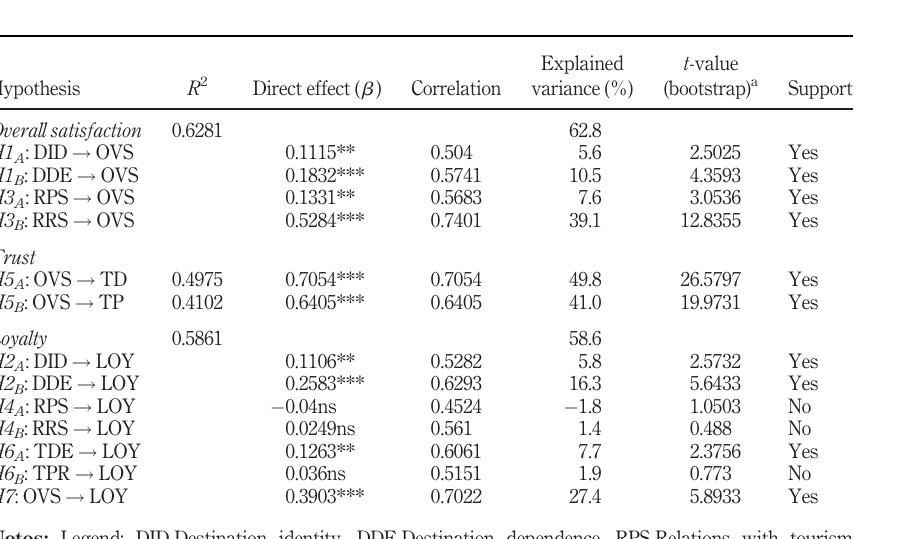
Table IV. Effects